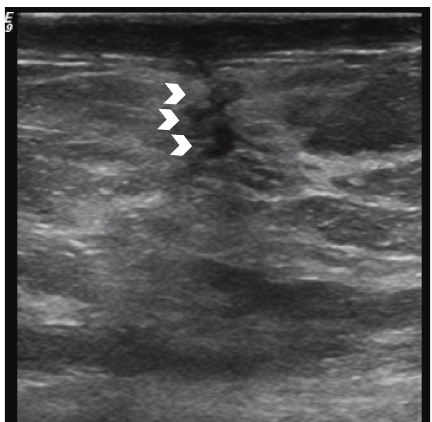
Figure 8: Follow-up ultrasound after surgical excision. A linear hypoechoic tract (arrowheads) can be seen at the site of surgery consistent with a surgical scar. No nodular soft tissue mass is identified to suggest residual